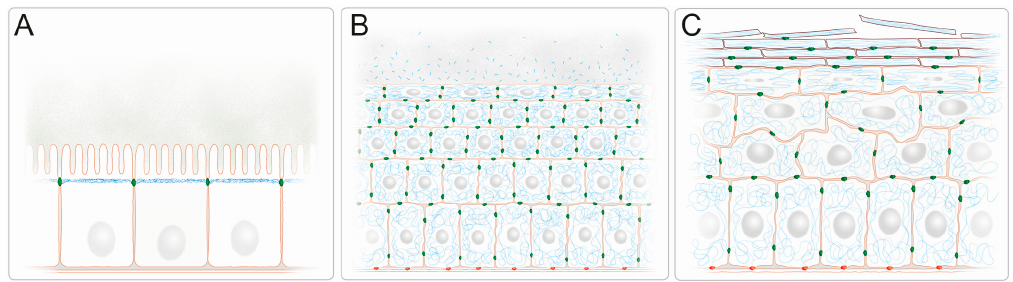
Figure 1. IFs form complex three-dimensional networks with cell type specific subcellular arrangements providing barrier function in simple and stratified epithelia. ( A ) Keratin IFs (blue) are subapically enriched in a dense filamentous network in the simple epithelium of the intestine. They localize just below the microvillar brush border that protrudes into the nutrient-filled intestinal lumen. The cylindrical epithelial cells are connected by junctional complexes, which encompass keratin-anchoring desmosomes (green), and rest all on a basal lamina; ( B ) The keratin IFs (blue) of the stratified epithelium of the cornea form dense 3D-networks that traverse the entire cytoplasm and are attached to desmosomes (green) at cell-cell contact sites. Keratin fragments with antibacterial activity are released into the tear fluid. The keratin cytoskeleton of the basal cells is anchored to hemidesmosomes (red), which attach to the underlying extracellular matrix of the basement membrane; ( C ) The keratin IF cytoskeleton of the epidermis, which is the prototype of a multilayered cornified epithelium, increases in density in the flattened suprabasal cell layers and becomes compacted as part of the cornified envelope of the dead cells in the uppermost stratum corneum which are continuously shed from the epithelium. While desmosomes (green) are present in all cell layers, hemidesmosomes (red) are restricted to the cuboidal basal cell layer.